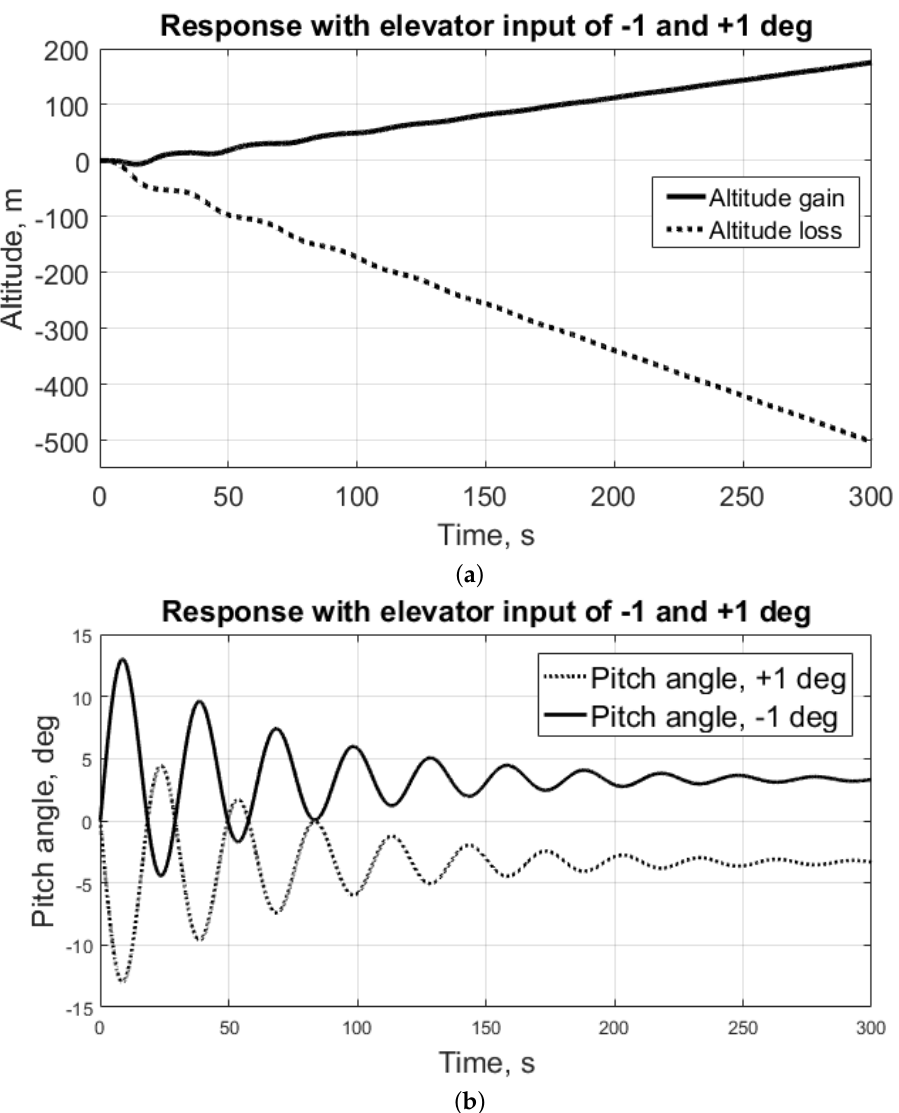
Figure 3. Response of the aerodynamic model of A UAV with negative and positive elevator inputs. ( a ) Effect on altitude. ( b ) Effect on pitch angle